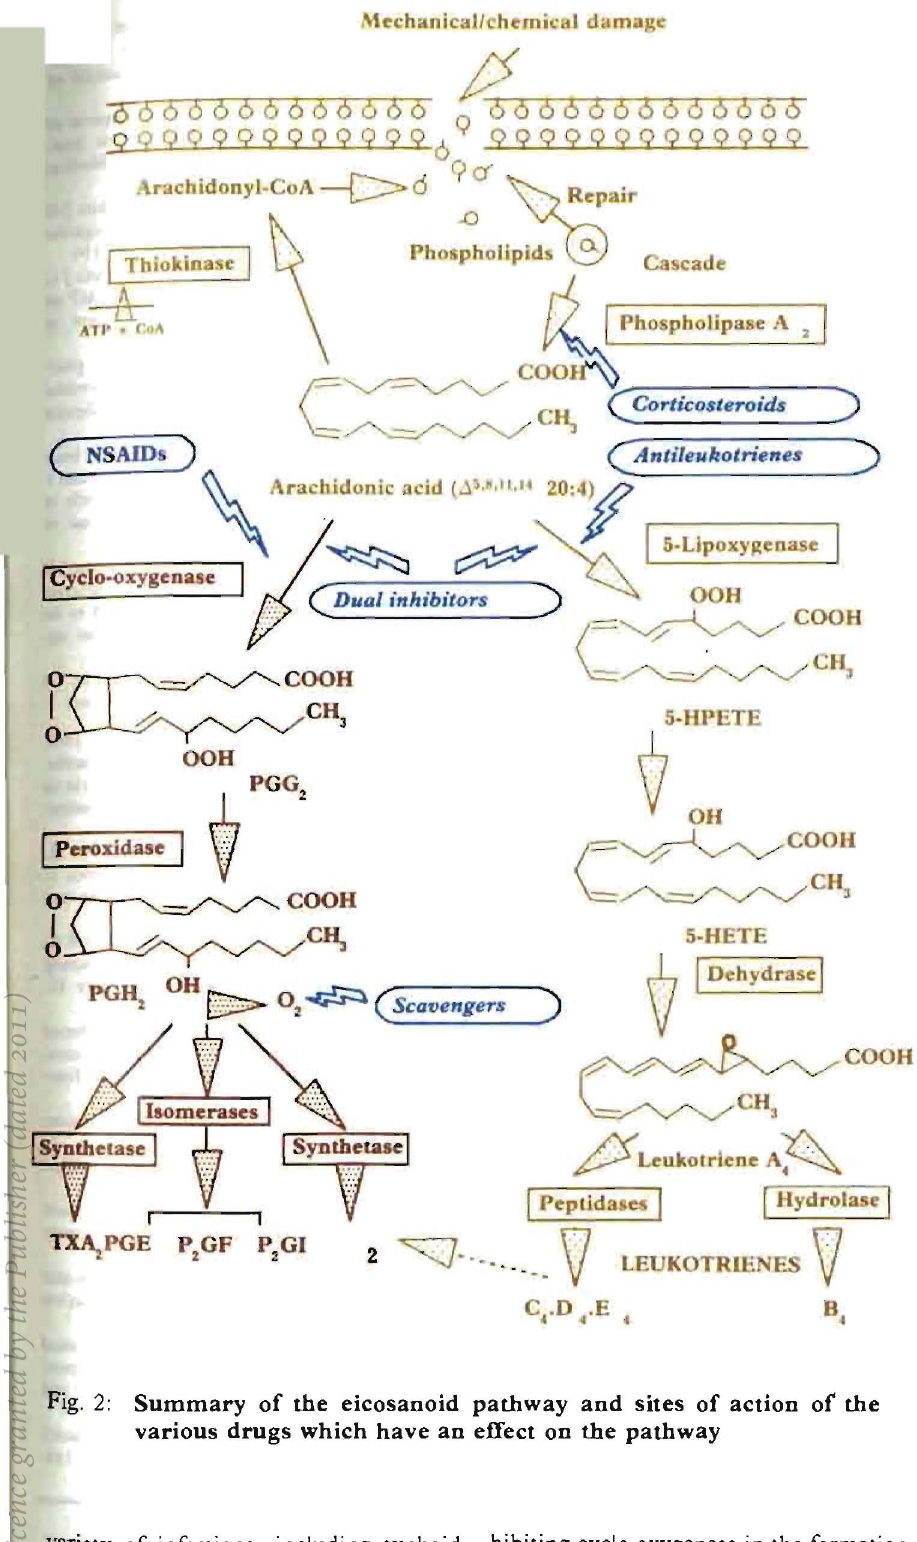
variety of infections, including typhoid and viral encephalitis32. The febrile effect of these prostaglandins appears to be as result of a action on the anterior hypothalamus7. Blocking the formation of prostaglandins probably accounts for the antipyretic action of many